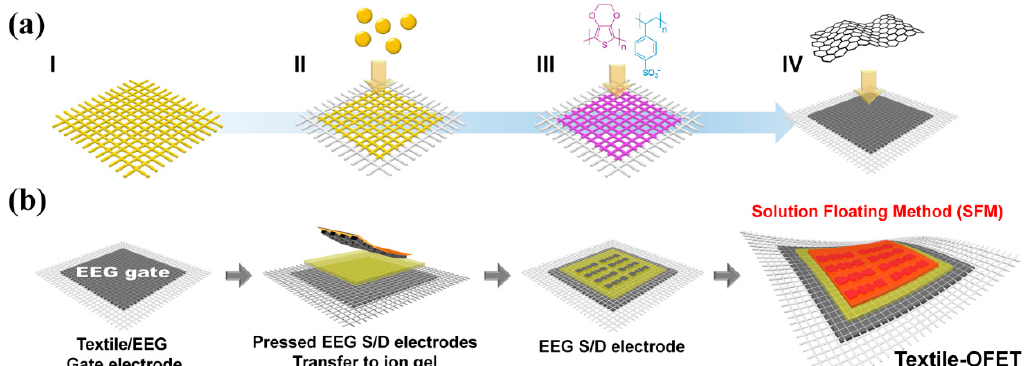
Figure 1. ( a ) Schematic illustration of four methods to produce textile-based electrodes for wearable transistors: (I) utilizing metal wire and mesh, (II) coating metal particles onto textile, (III) conducting polymer coating, and (IV) nano-carbon coating. ( b ) Schematic illustration of the fabrication of a textile-OFET using hot-pressed EEG electrodes.